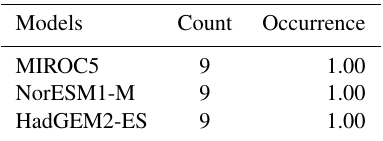
Table C6. Absolute and relative occurrence of each individual model included in the Greenland top three combinations presented in Table C5.